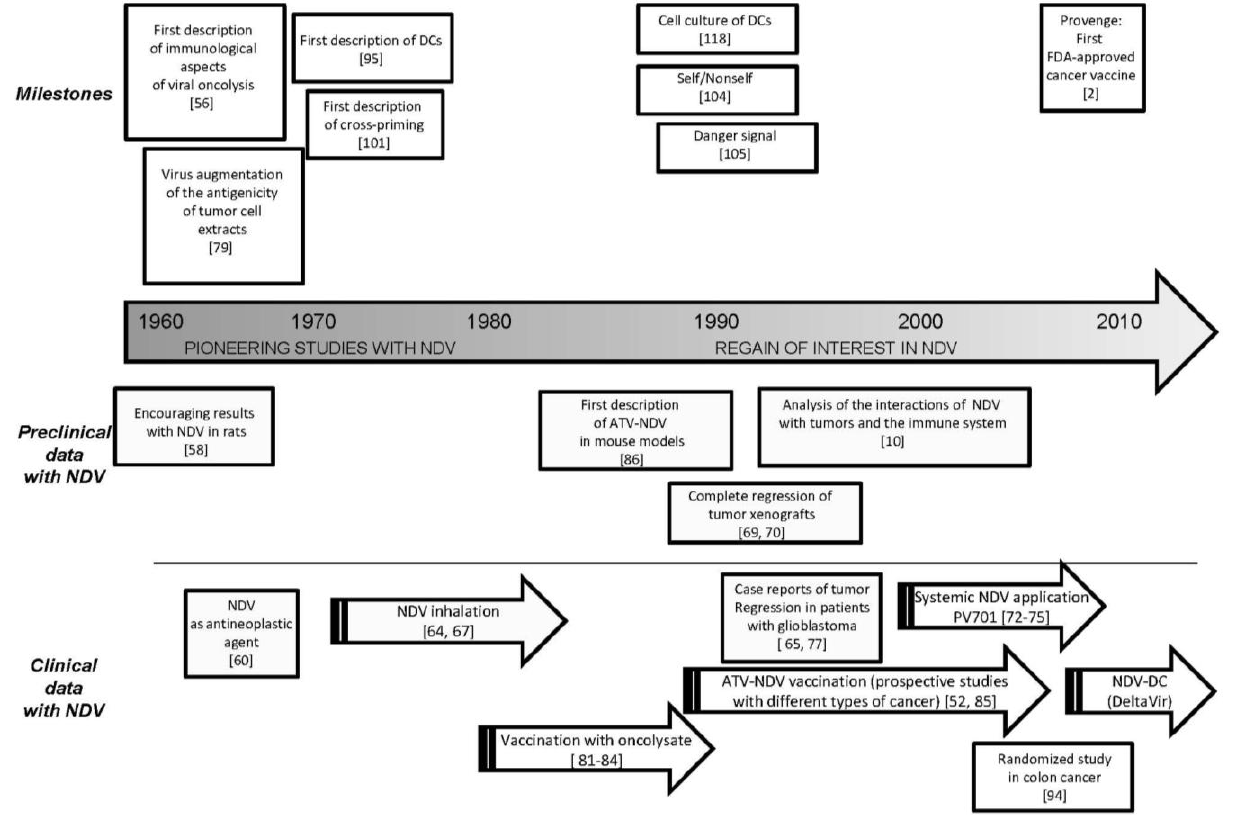
Figure 6. History of the development of cancer therapy based on NDV and the immune system (see the main text for more